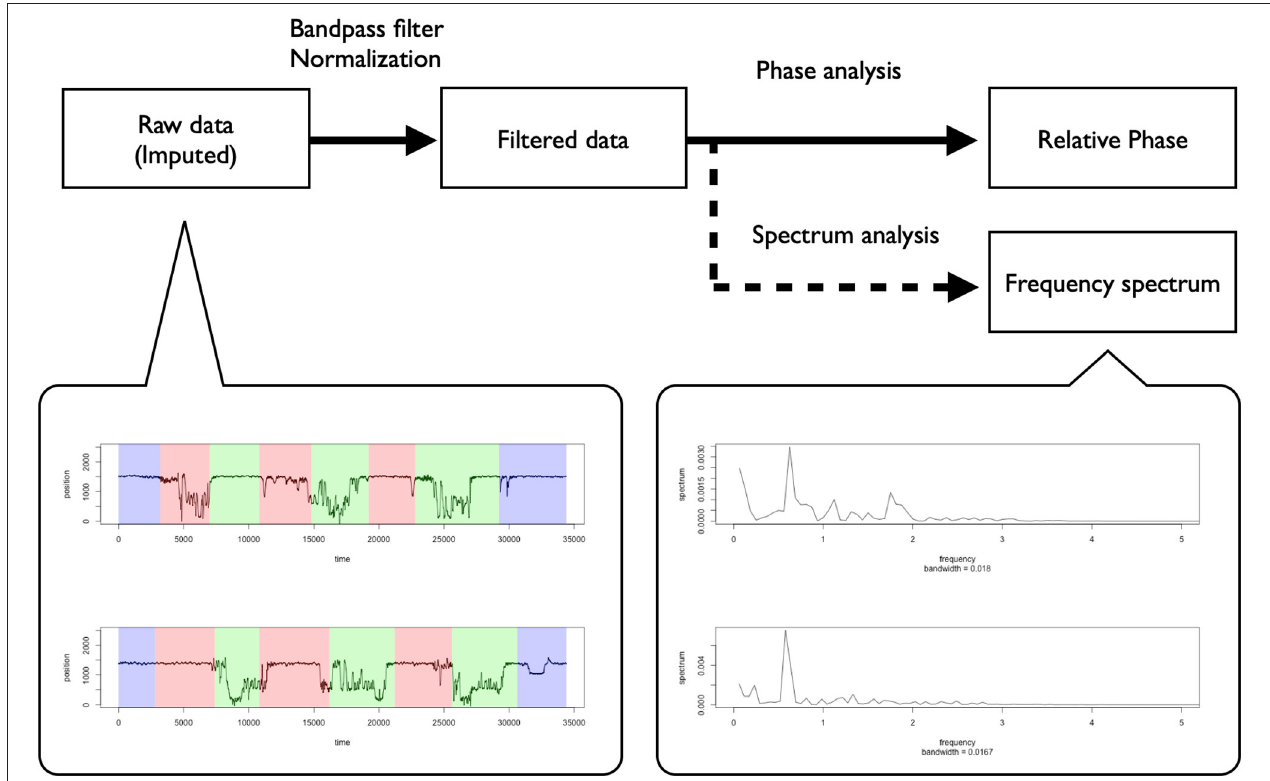
FIGURE 2 | Normalization procedures and the representative examples of raw data (Whole turns) and spectrum analysis (Turn 1) of individual-level rhythmic movement data.